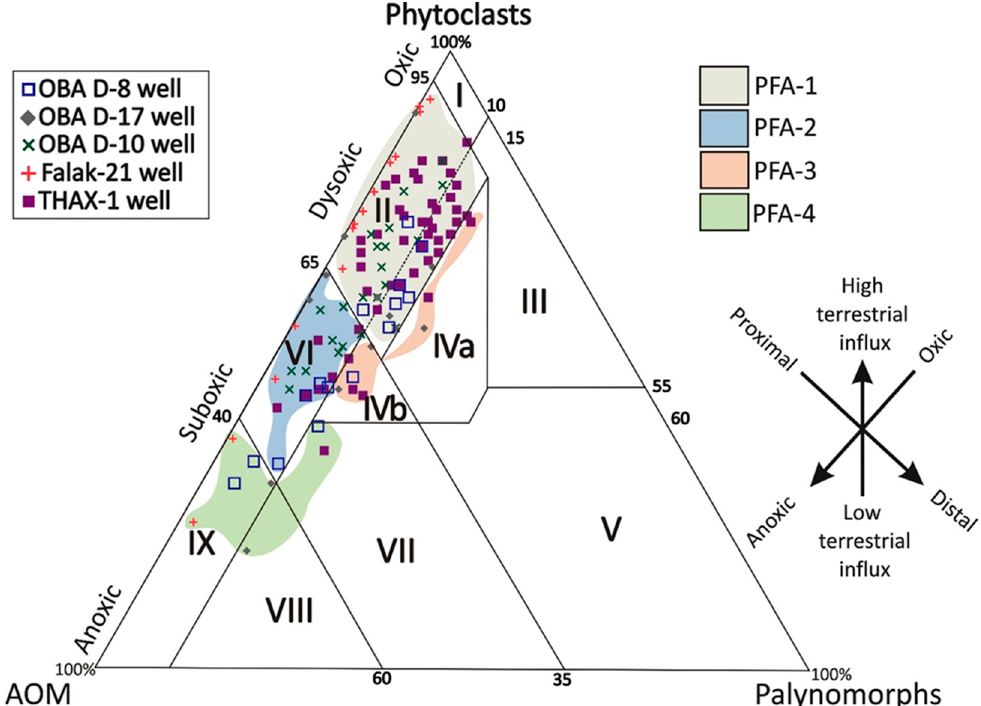
Figure 8. Ternary diagram of the three endmembers of AOM-Phytoclasts-Palynomorphs (APP, after [12]) shows the distribution of majority of the Khatatba Formation samples in the fi ve studied wells in palynofacies fi elds II, IV and VI, and few samples plot in palynofacies fi elds IX and VIII.